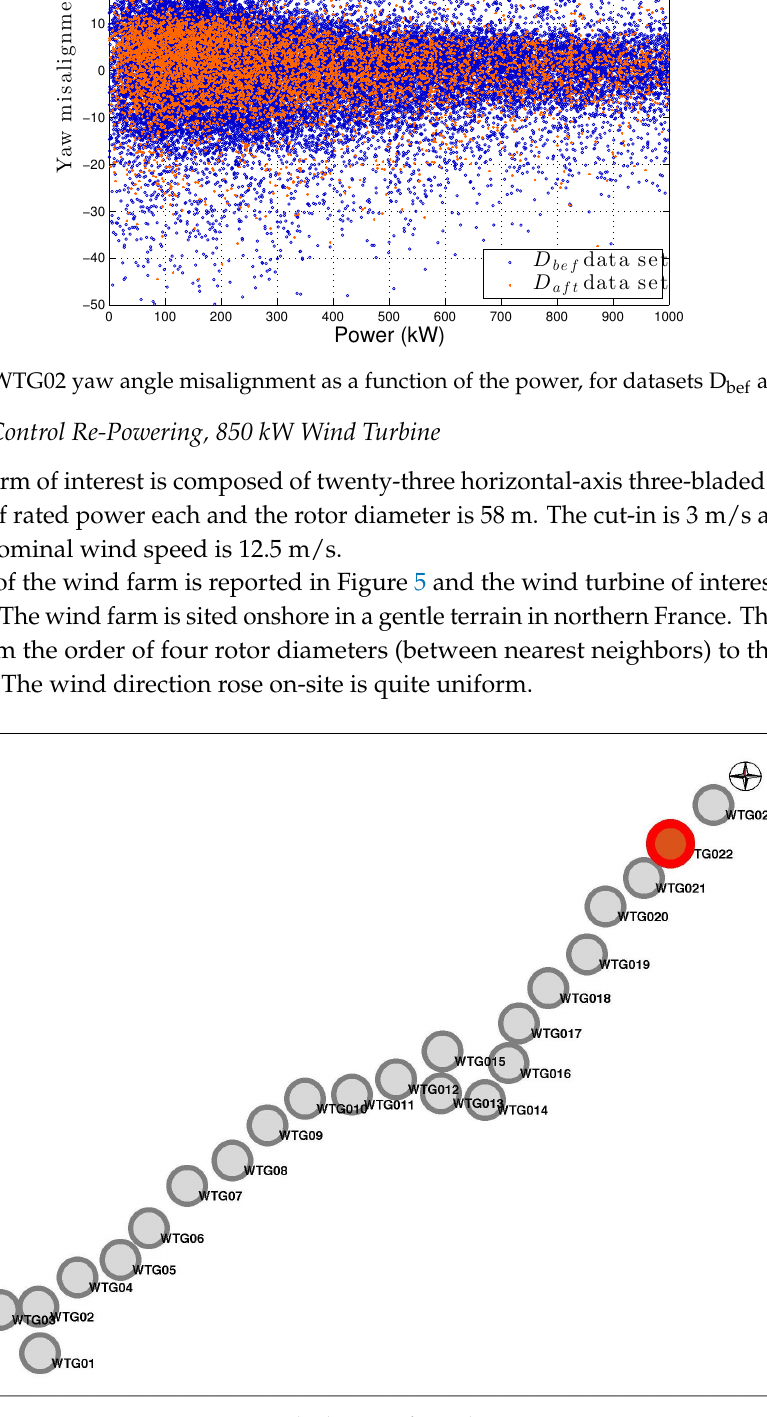
Figure 5. The layout of Wind Farm